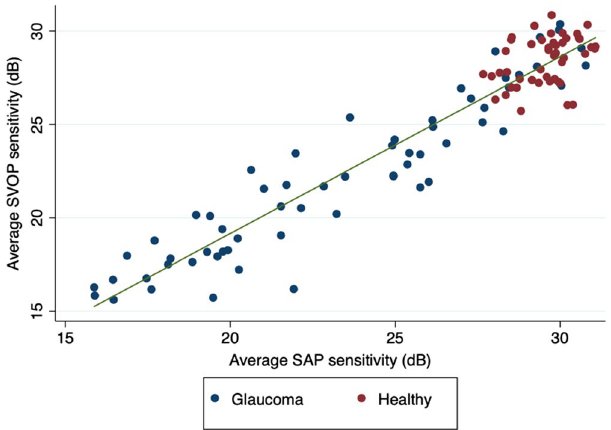
Figure 2. Relationship between average standard automated perimetry (SAP) and saccadic vector optokinetic perimetry (SVOP) sensitivity for healthy and glaucomatous